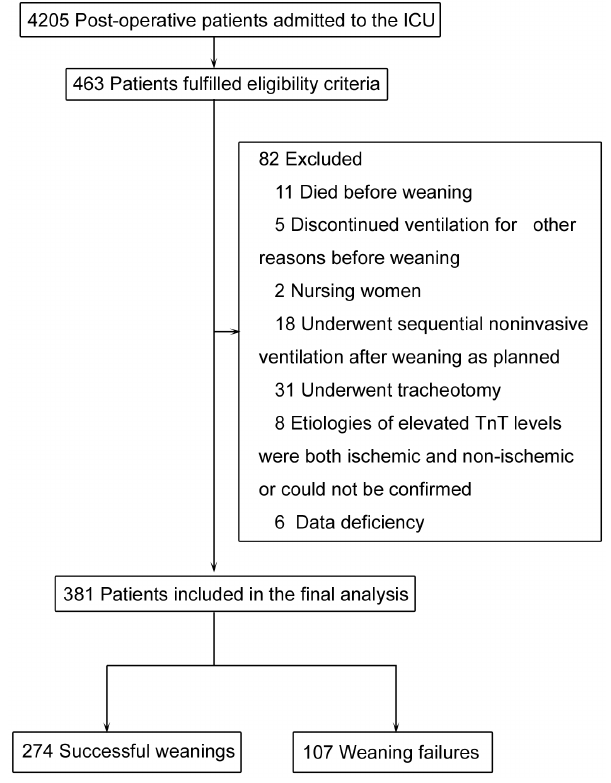
Figure 1. Patient flow chart.